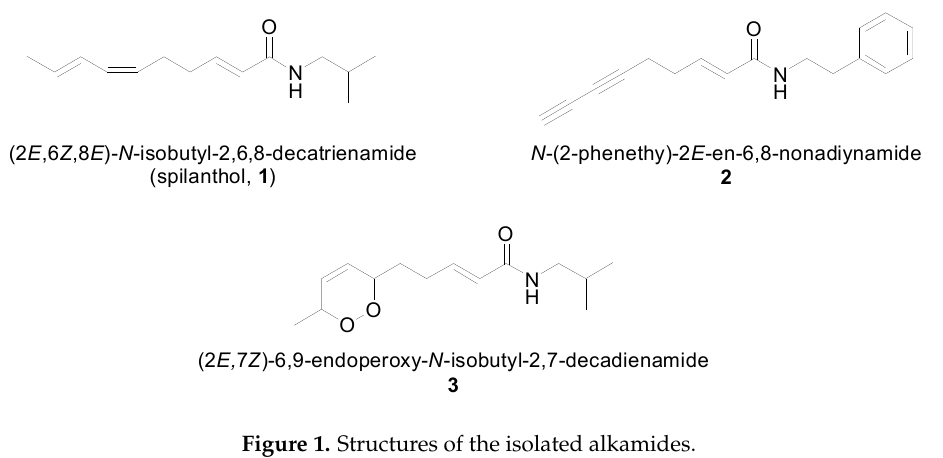
Figure 1. Structures of the isolated alkamides.